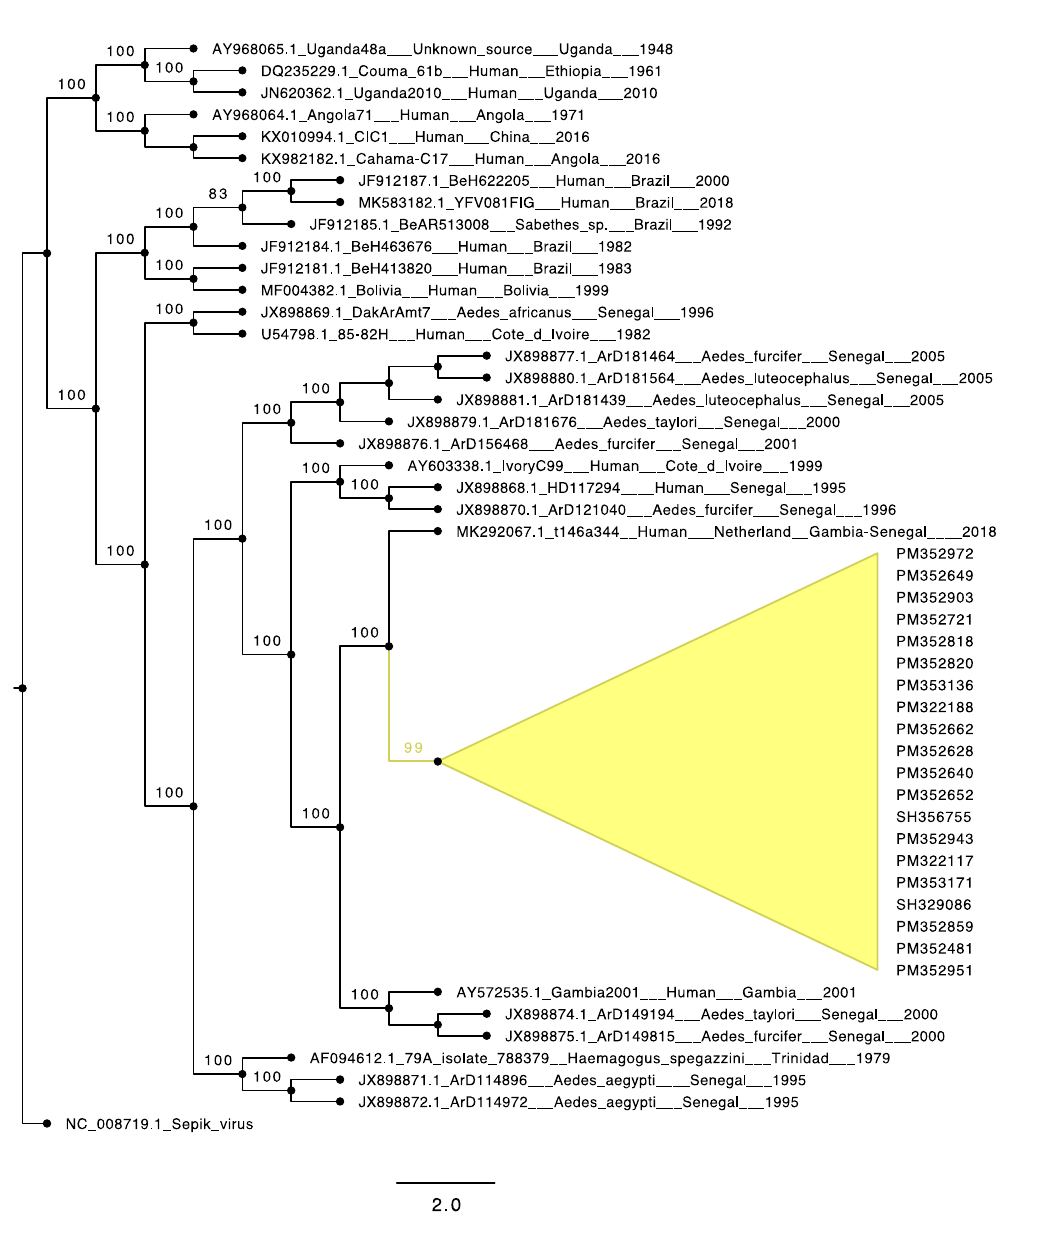
Figure 1. Sepik virus-rooted maximum-likelihood phylogenetic tree of yellow fever virus strains from different genotypes. (Newly sequenced yellow fever viruses are shown in yellow).